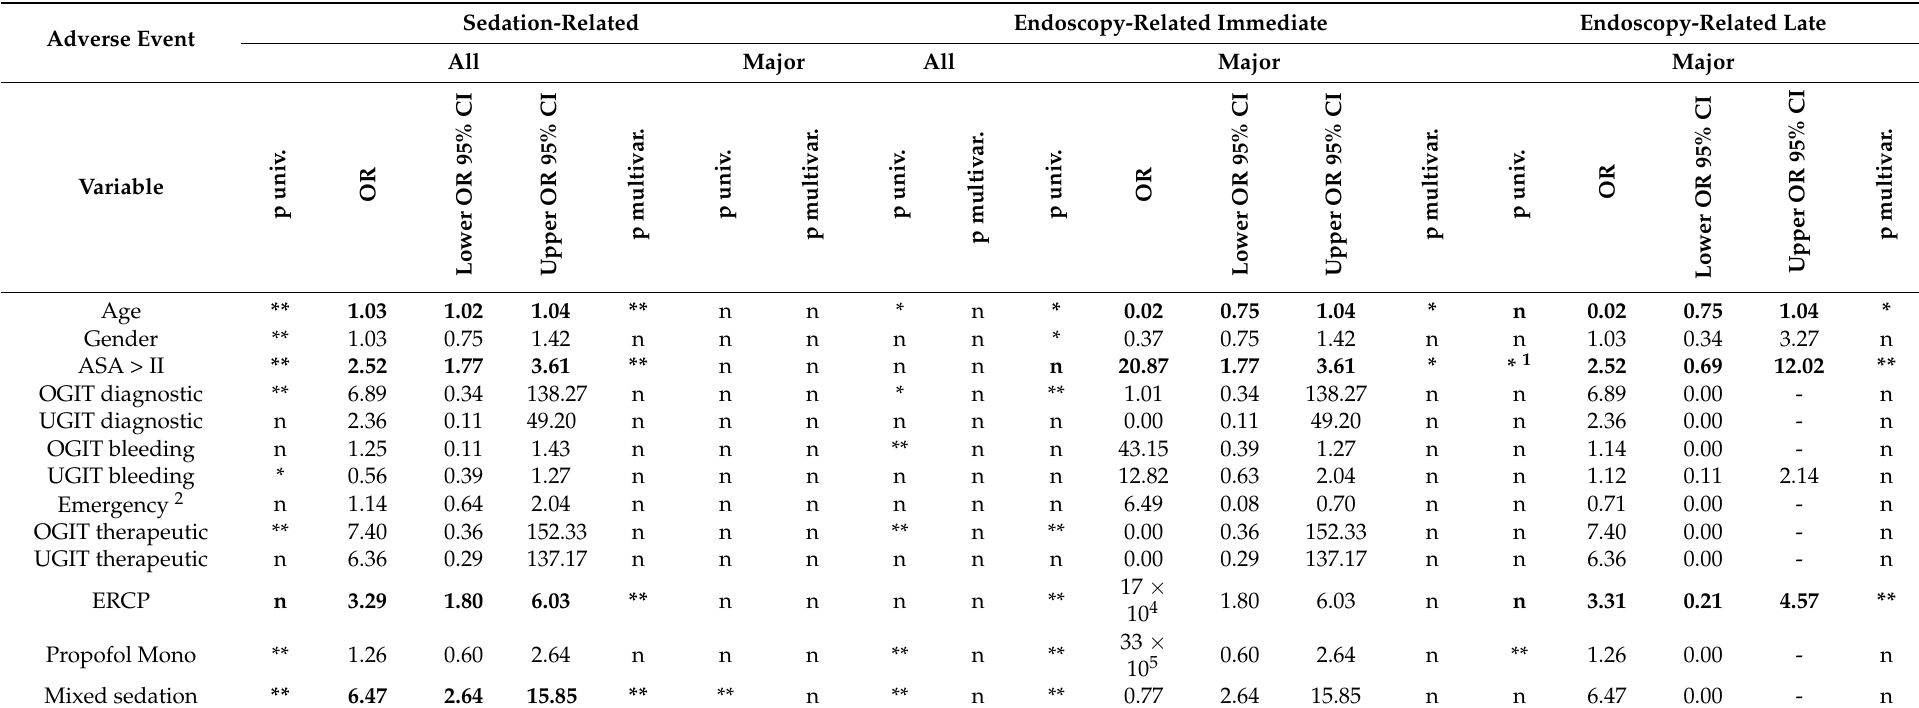
Table 6. Selective multivariate logistic regression analysis. Factors and